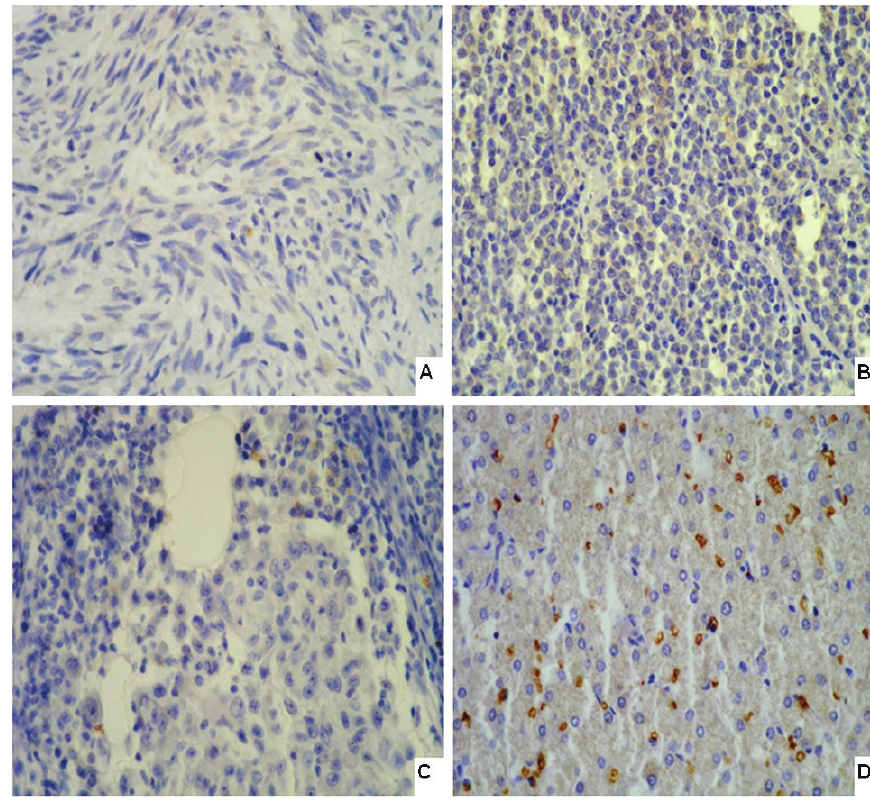
Figure 2 - Absence of GLUT1 expression. A, sarcoma sample; B, lymphoma; C, melanoma; D,